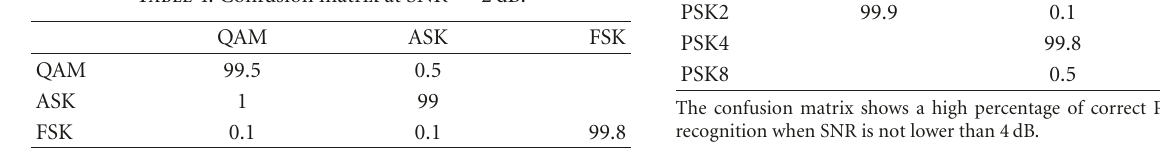
Table 4: Confusion matrix at SNR = − 2 d B.